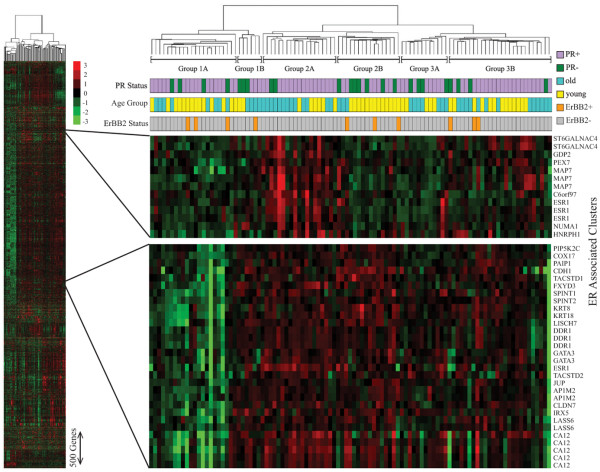
Hierarchical clustering of primary estrogen receptor-positive breast cancers based on genome-wide microarray profiling. Unsupervised hierarchical clustering of 101 primary estrogen receptor (ER)-positive breast cancers, diagnosed in younger women (age ≤ 45 years) or older women (age ≥ 70 years), based on genome-wide microarray profiling of 6,632 variably expressed probes (~5.1 K unique genes). The cluster dendrogram defines six different transcriptome subtypes of ER-positive breast cancers (Group 1A, 1B, 2A, 2B, 3A, 3B), with significant age biases (P < 0.05) but not biased by progesterone receptor (PR) status or ERBB2 status; horizontal colored bars identify the age cohort, PR status and ERBB2 status of the ER-positive samples in each column. The vertical red–green color scale shows log2 ratios from mean centered gene expression levels. Magnified views show ESR1-containing (ER-associated) probe sets within the entire cluster diagram.